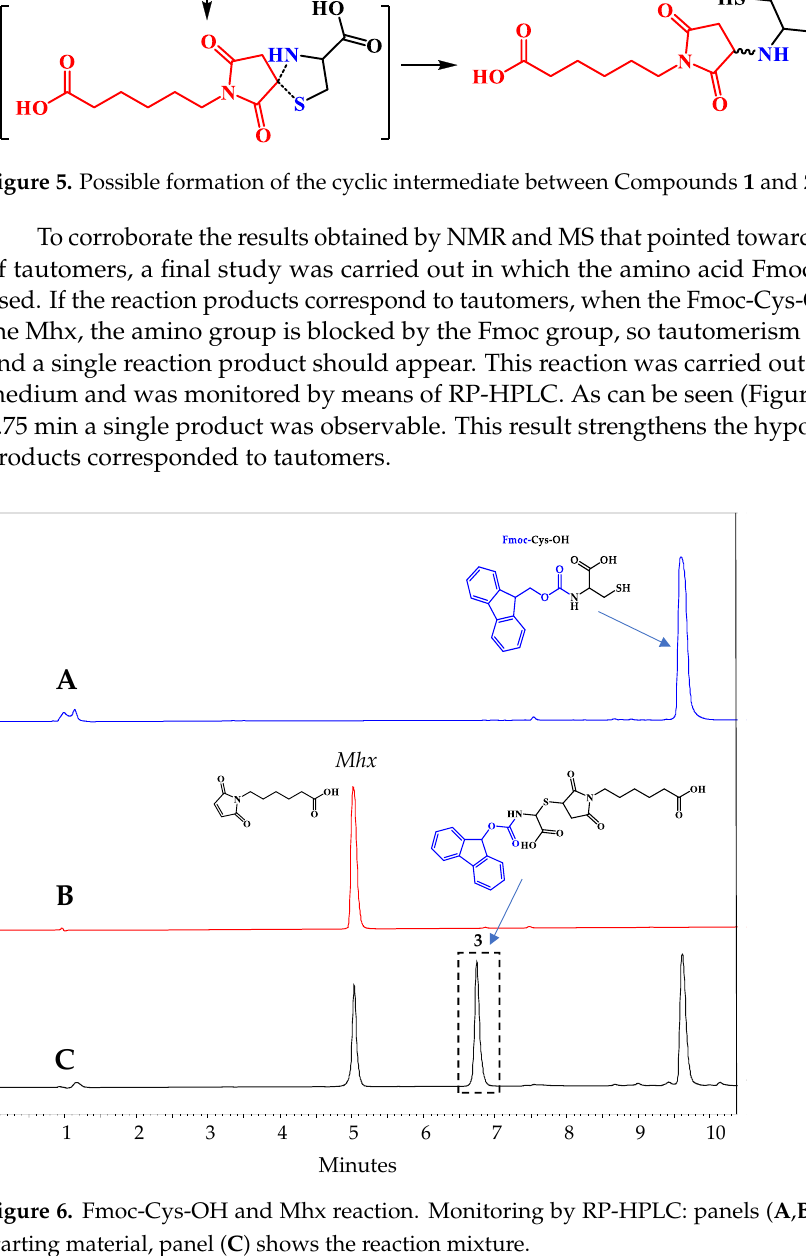
Figure 7. Chromatogram of the reaction mixture between L-cysteine and N -(2-aminoethyl)malei- mide in H 2 O/MeOH 80:20.